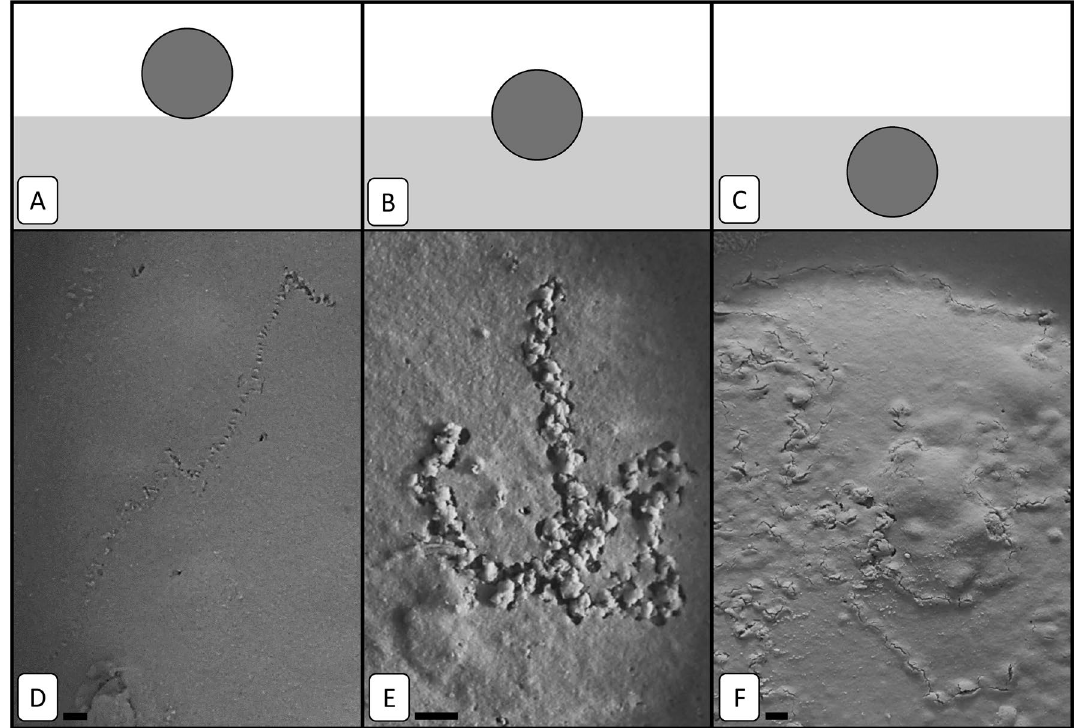
Figure 1. Schematic side-view representation of the vertical position ( A – C ) and top-view images of the sediment surface showing actual trajectories of foraminifera ( D – F ) related to the three vertical position categories, which can be taken by a foraminifera, i.e. surface ( A , D ) sediment–water interface, ( B , E ), and burrowed ( C , F ). Scale bars = 0.2 mm. From Deldicq et al. 48